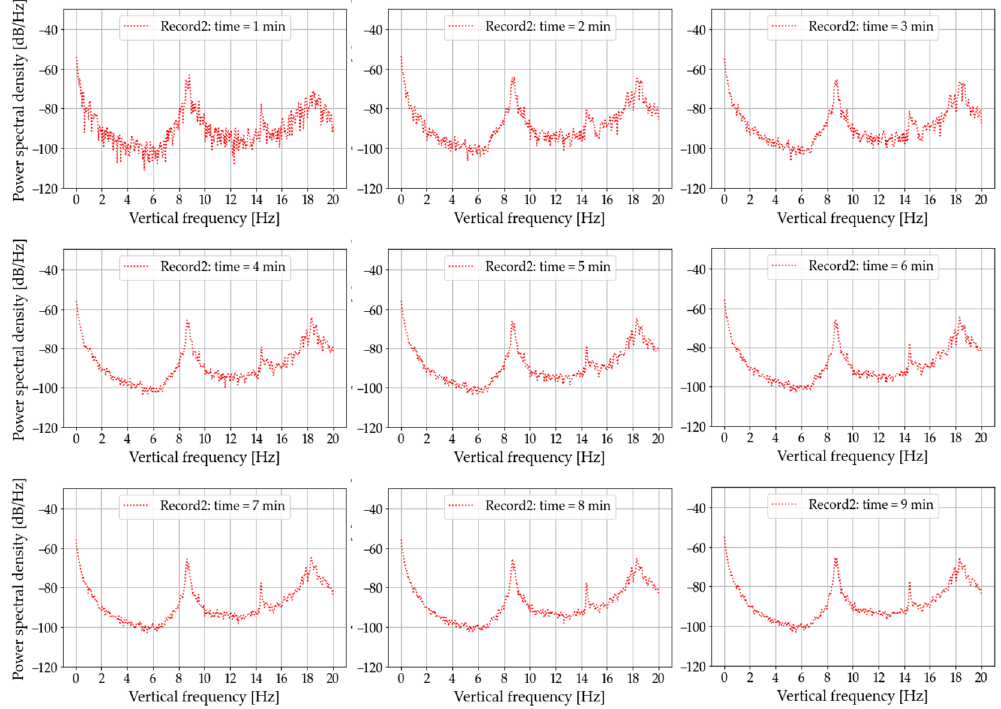
Figure 17. Power spectral density of the last nine vertical frequency observations of the Sagrado bridge.